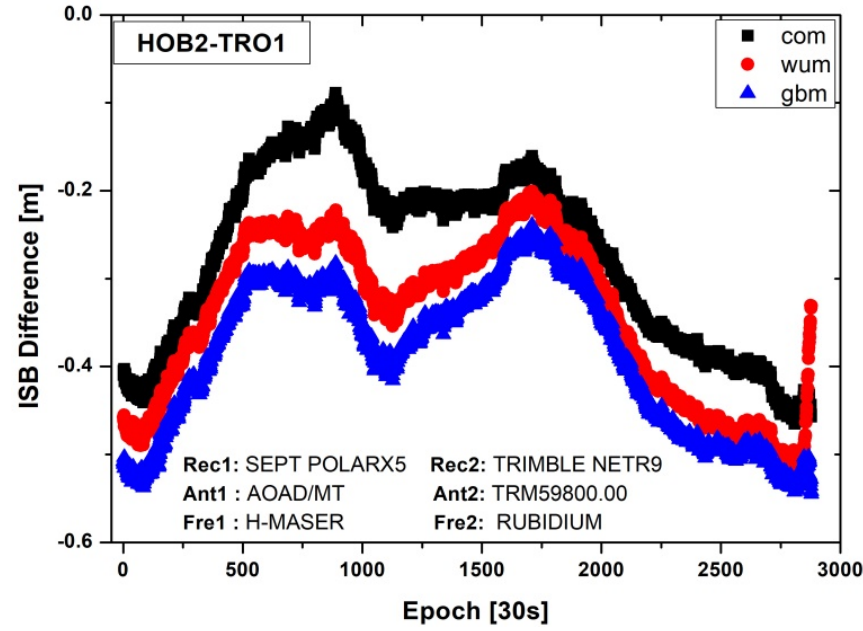
Figure 8. ISB difference series for scheme 5 on DOY 119, 2021.